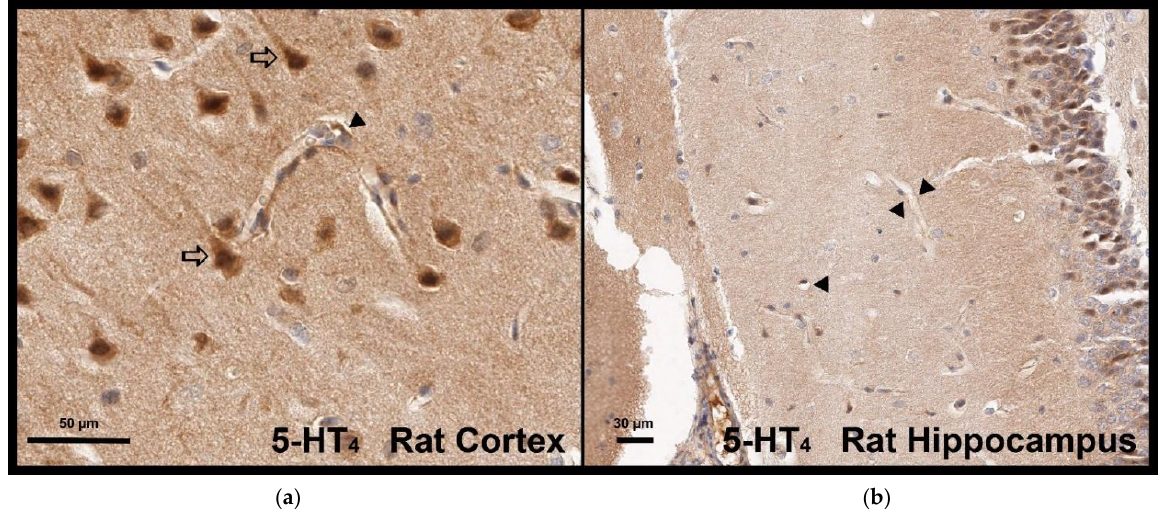
Figure 8. Expression of the 5-HT 4 receptor by endothelial cells of capillary vessels in the rat cortex ( a ) and hippocampus ( b ). ( ) indicates neurons with 5-HT 4 labelling and ( (cid:182) ) indicates endothelial cells of capillary vessels.